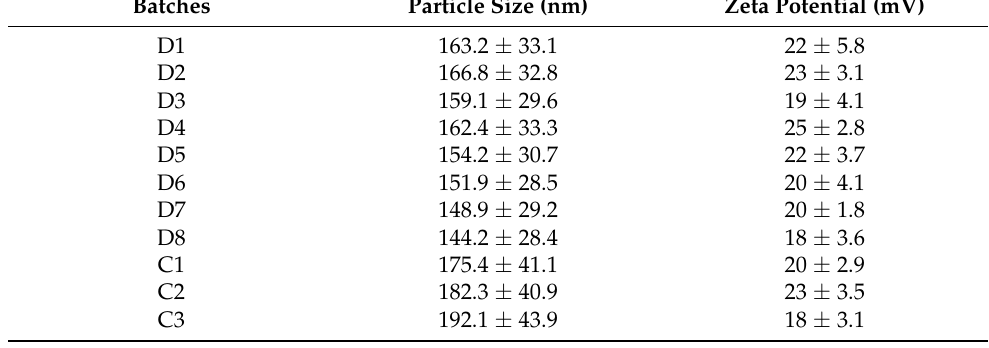
Table 6. Particle size and zeta potential of rivastigmine nanoparticles.